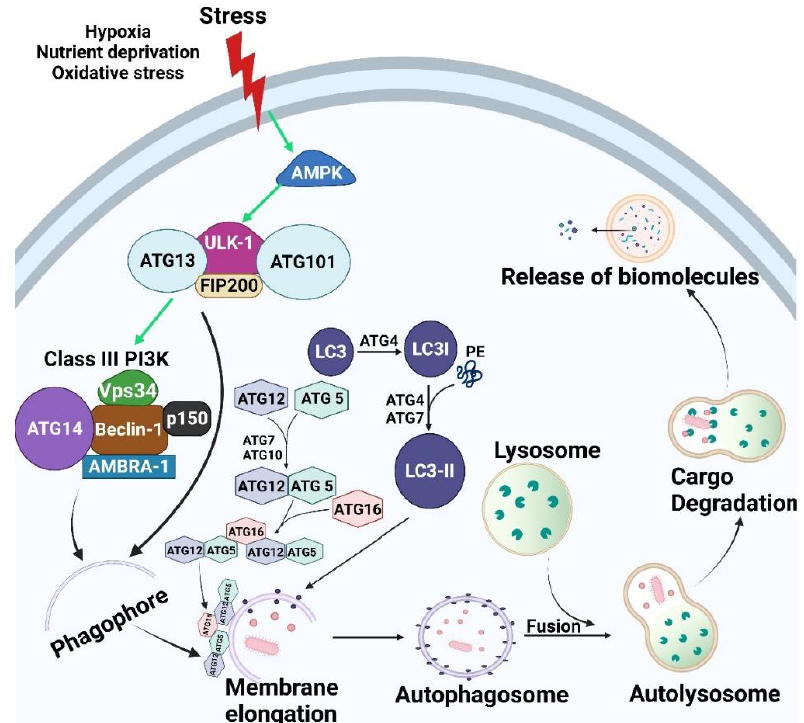
Figure 1. Autophagic pathway. As cells are subjected to micro environmental stress, AMPK activation occurs, which in turn leads to activation of ULK-1 complex (ULK-1, ATG13, ATG101 and FIP200). ULK-1 complex activation results in assembly of Class III PI3K (Beclin-1, Vps34, AMBRA, p150 and ATG14). Both ULK-1 complex and Class III PI3K translocate to the nucleation site and stimulate formation of the isolation membrane known as the phagophore. Elongation of the phagophore occurs via the effect of both LC3-II and ATG5-ATG12-ATG16 until a double membrane vesicle is formed, which is known as the autophagosome. Autophagosomes fuse with the lysosome which leads to cargo degradation via effect of lysosomal enzymes with release of biomolecules. Green arrows indicate activation. Created with BioRender.com (accessed on 15 October 2021).